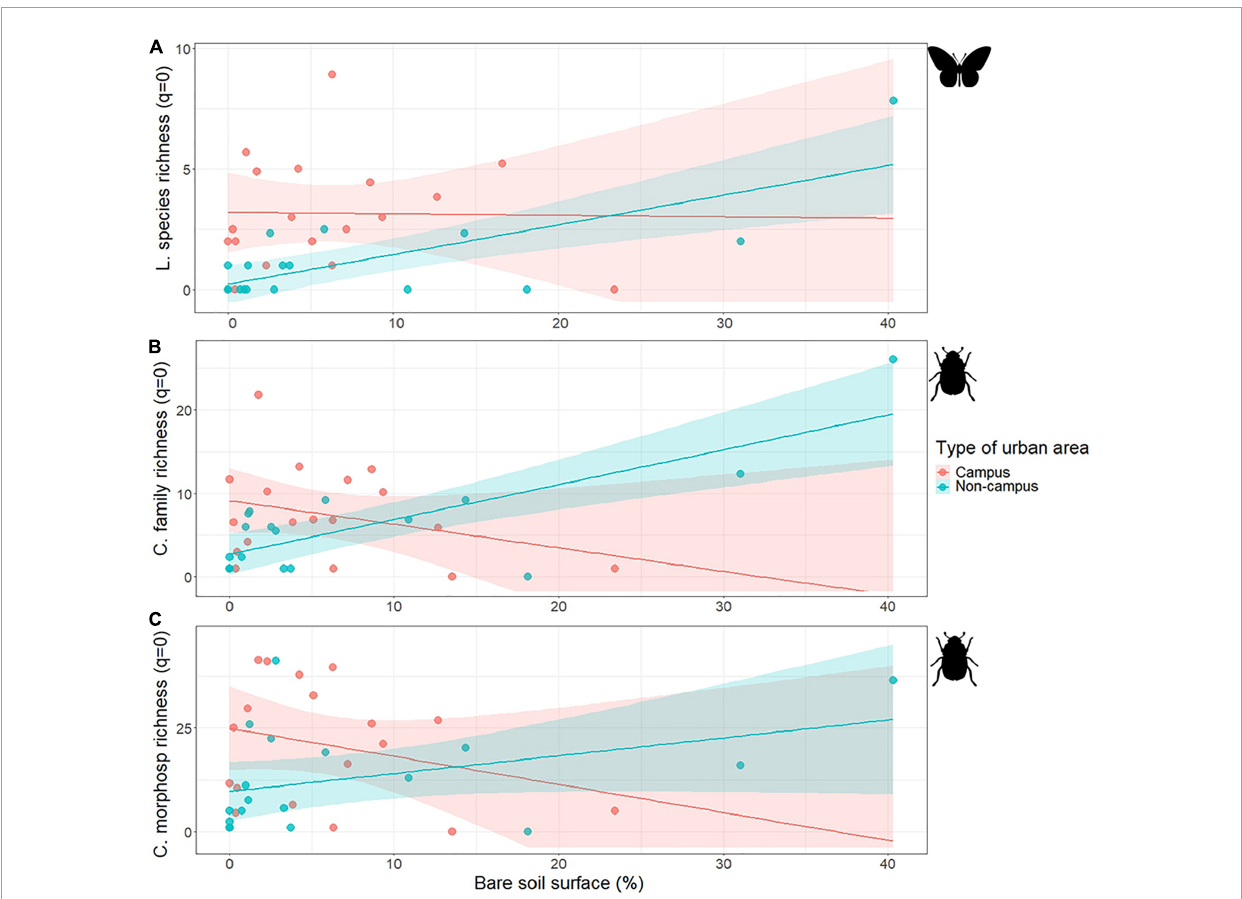
FIGURE2 Association between the diurnal Lepidoptera species (A) , the ground-dwelling Coleoptera family (B) and morphospecies (C) richness ( q = 0) and the bare soil surface in combination with the type of urban area. Colored bands represent confidence intervals.